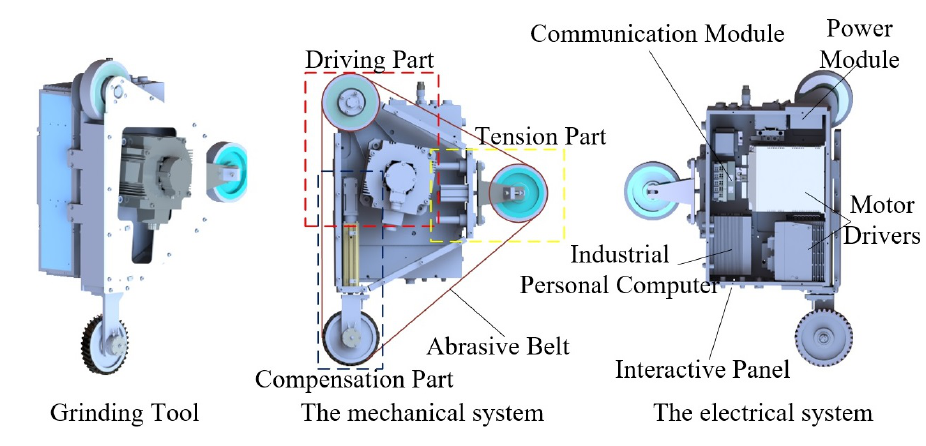
Figure 3. Design of the grinding